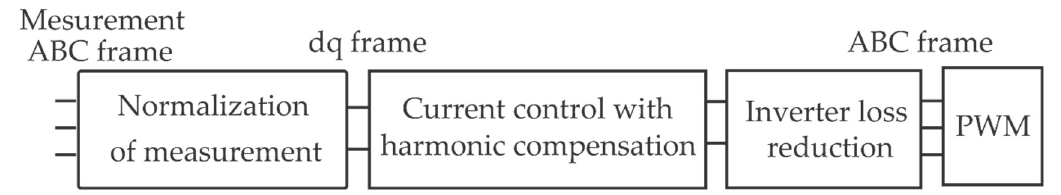
Figure 5. Detailed view of the control system of the VSC of HRES.